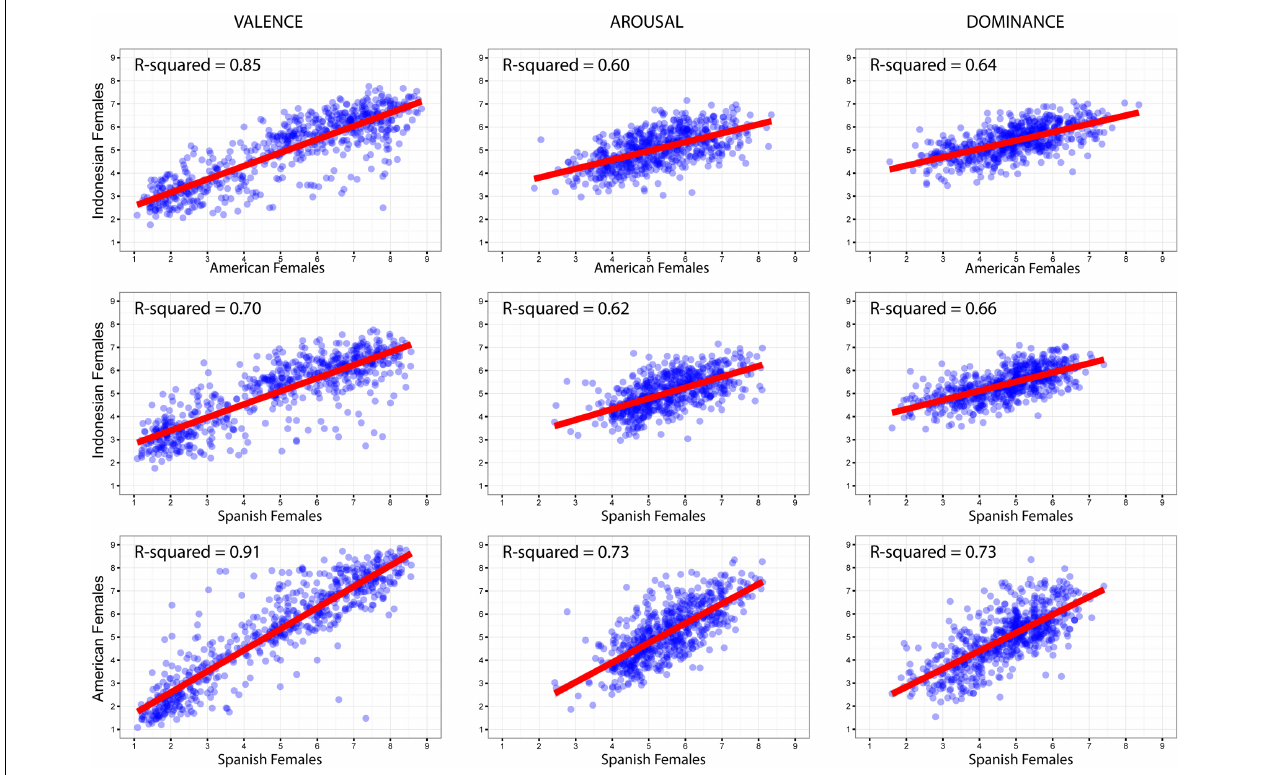
FIGURE 8 | Cross-cultural regression analyses on women’s